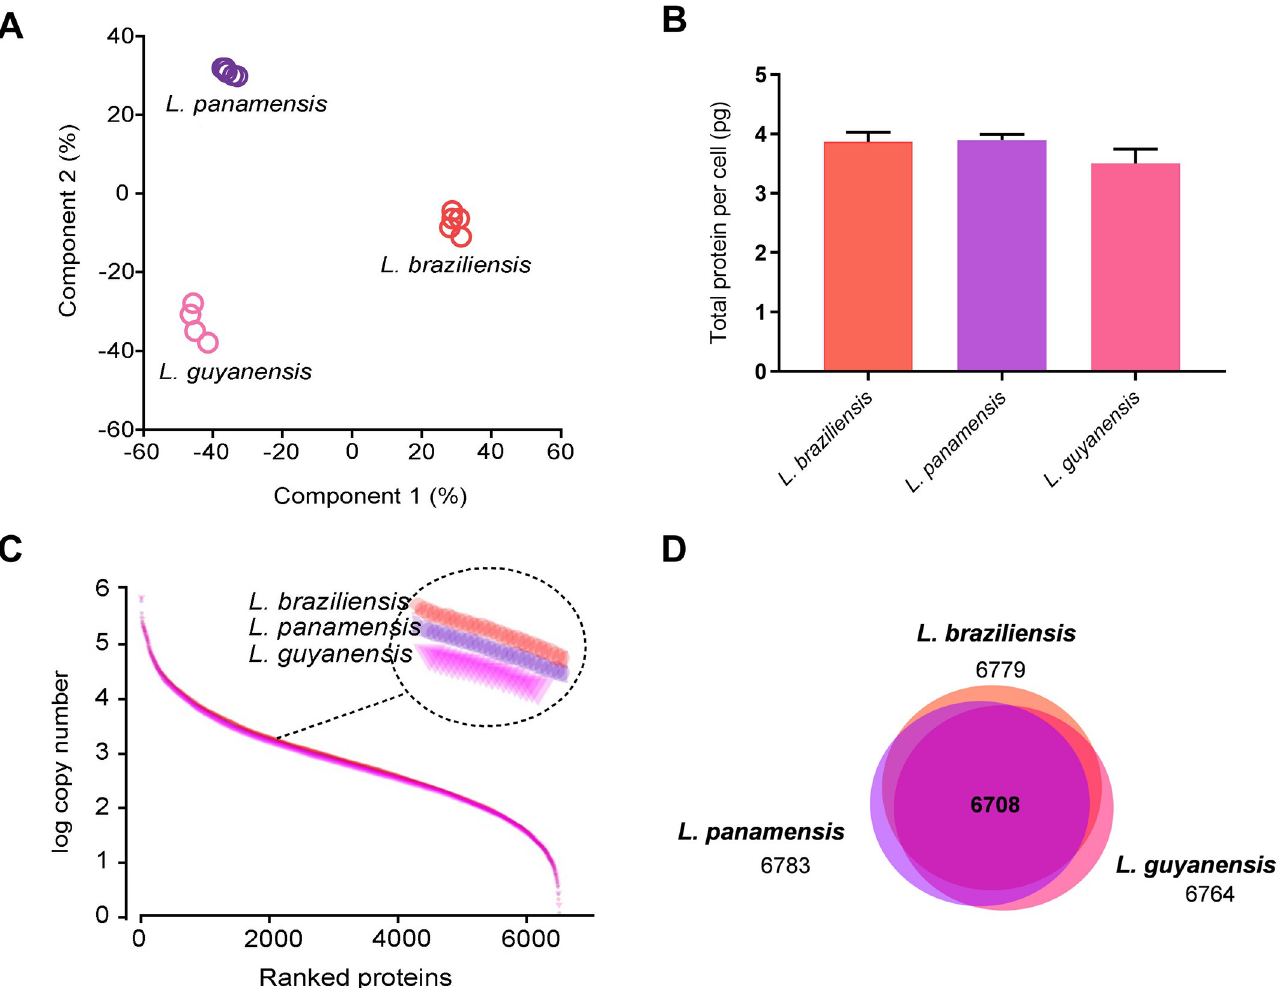
Fig 1. Description of the Leishmania ( Viannia ) proteomes. Whole cell lysates from L . braziliensis , L . panamensis and L . guyanensis were processed by MED-FASP and analyzed by LC-MS/MS. Protein abundances were calculated based on the raw spectral intensities. (A) Principal component analysis of the protein concentration values of all identified proteins determined by the Total Protein Approach , (TPA), method. The close clustering of each set of biological replicates reveals accurate reproducibility among independent biological samples. (B) Total protein content per cell, n = 5 biological replicates for L . braziliensis and L . panamensis and n = 4 for L . guyanensis . Values are expressed in pg ± SD. (C) Dynamic range of protein copy numbers across all proteins identified in each species. Protein abundances were ranked from the highest to the lowest copy number in the Leishmania samples. (D) Venn plot with number of proteins identified in each species.